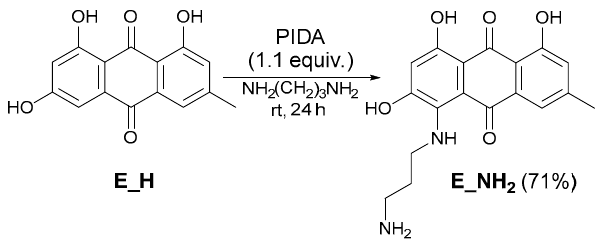
Figure 2. Synthesis of amino emodin E_NH 2 .